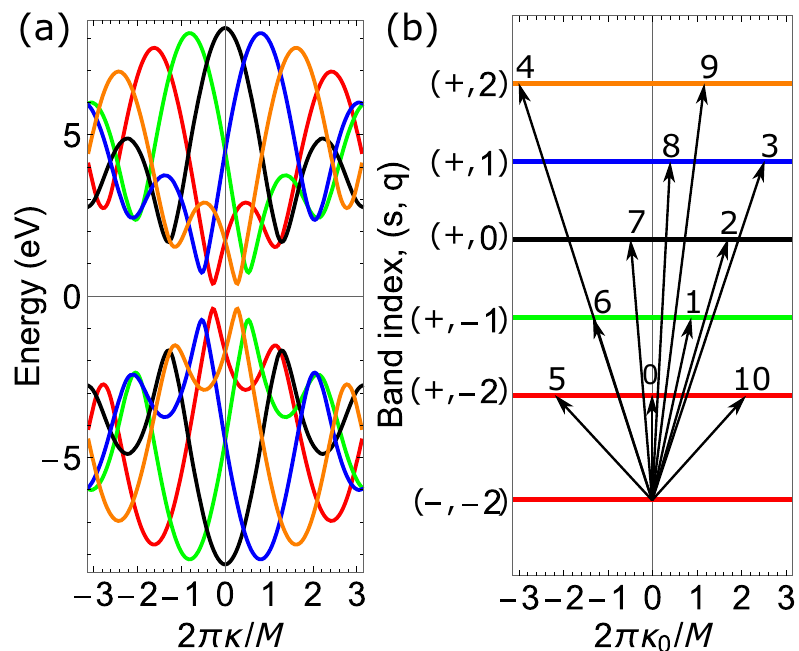
Fig. 5 Momentum conservation. a Band structure of the (5,10) CNT. The bands are associated with OAM = − 2 (red), − 1 (green), 0 (black), + 1 (blue), or + 2 (orange). b Absorption of helical moment by an electron in state (cid:4) ; (cid:4) 2 ; 0 j i when illuminated by twisted light with different PAM (numbers at